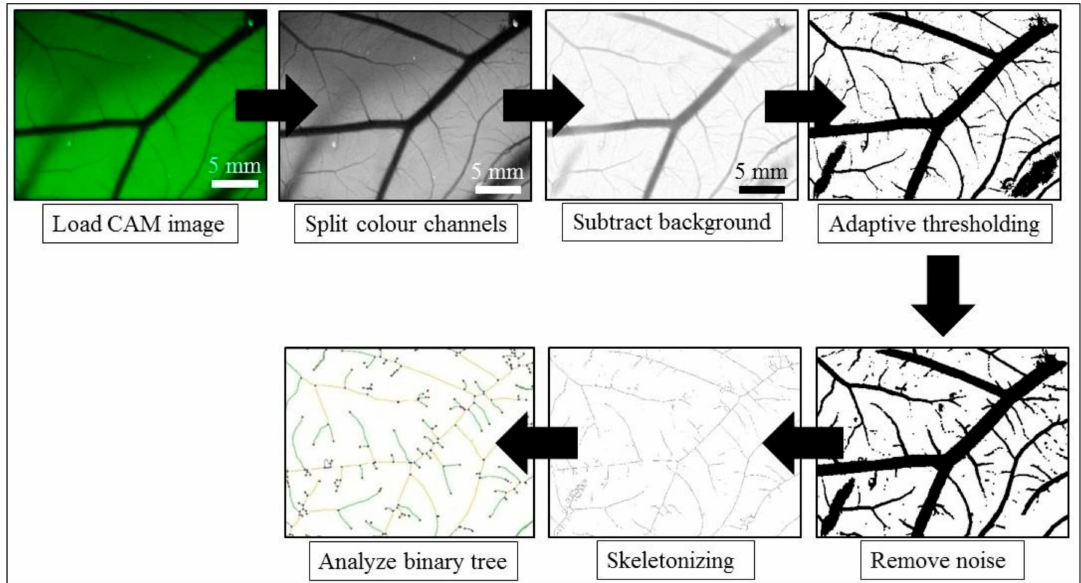
Figure A12. Algorithm used for the validation of induced blood vessel growth. Angiogenesis Analyzer was applied for the skeletonizing and analysis of the obtained binary tree.